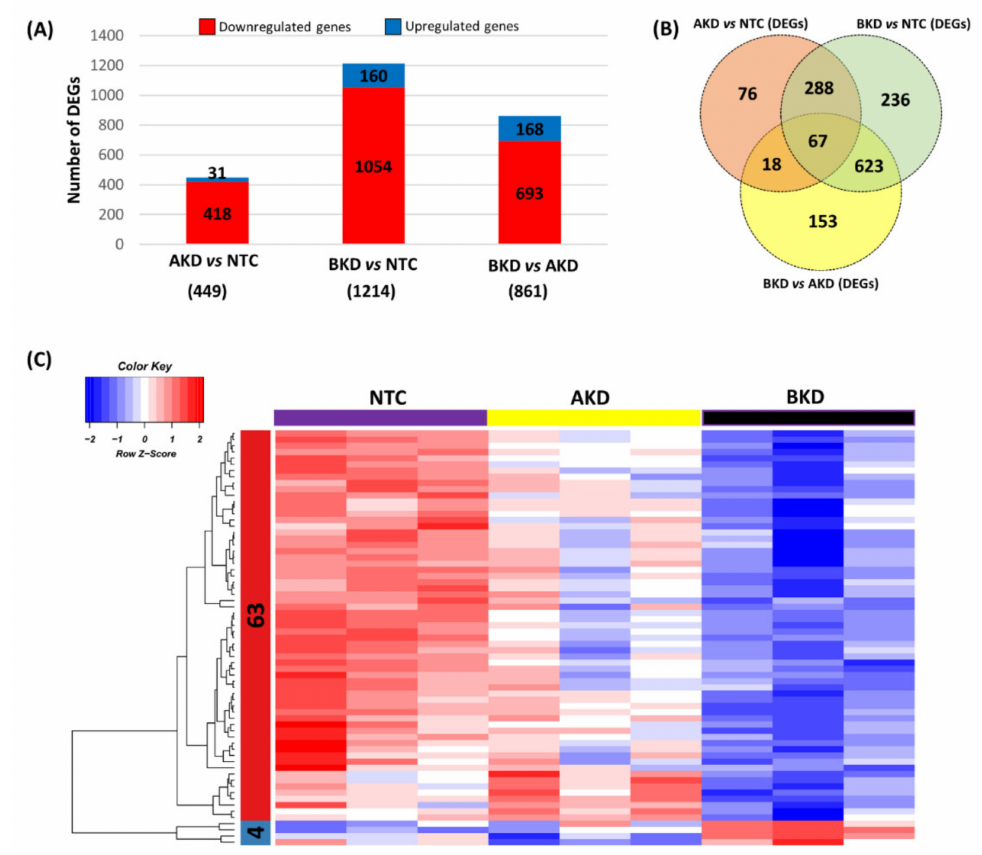
Figure 6. The common DEGs in different comparisons. ( A ) Bar plot showing the upregulated and downregulated DEGs in AKD vs. NTC, BKD vs. NTC, and BKD vs. AKD. ( B ) Venn plot using the total DEGs in AKD vs. NTC, BKD vs. NTC, and BKD vs. AKD. ( C ) The heatmap of the common DEGs in all comparisons. A total of 47 common DEGs were distributed in two clusters based on their co-expression with cut-off criteria of FPKM > 5, |logFC > 2|. In the color key, the red color represents upregulation, the blue color represents downregulation and the white color represents no change in